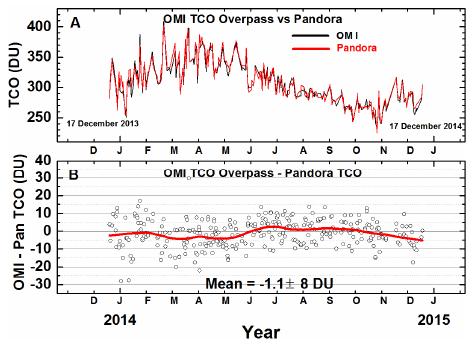
Figure 3. (a) Temperature-corrected retrieved TCO data obtained from the Dobson #061 instrument and Pandora #34 spectrometer. (b) The difference TCO(Dobson) – TCO(Pandora) with tempera- ture corrections removing most of the seasonal bias. The standard deviation from the red Lowess(0.5) curve is ± 5DU.